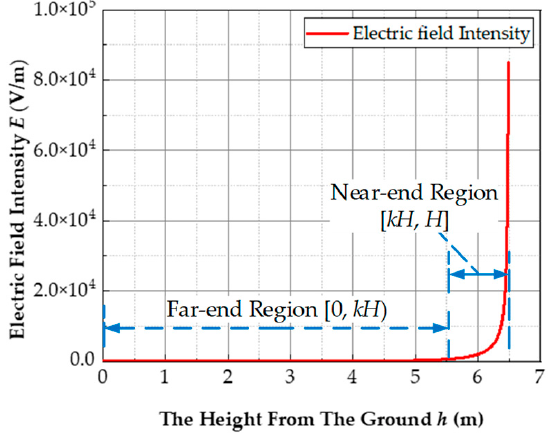
Figure 3. The electric-field distribution below the A-phase wire.